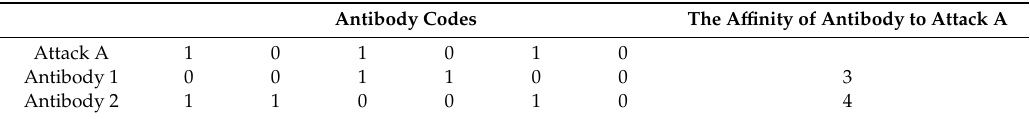
Table 4. An example for calculating the a ffi nities of two antibodies with respect to attack